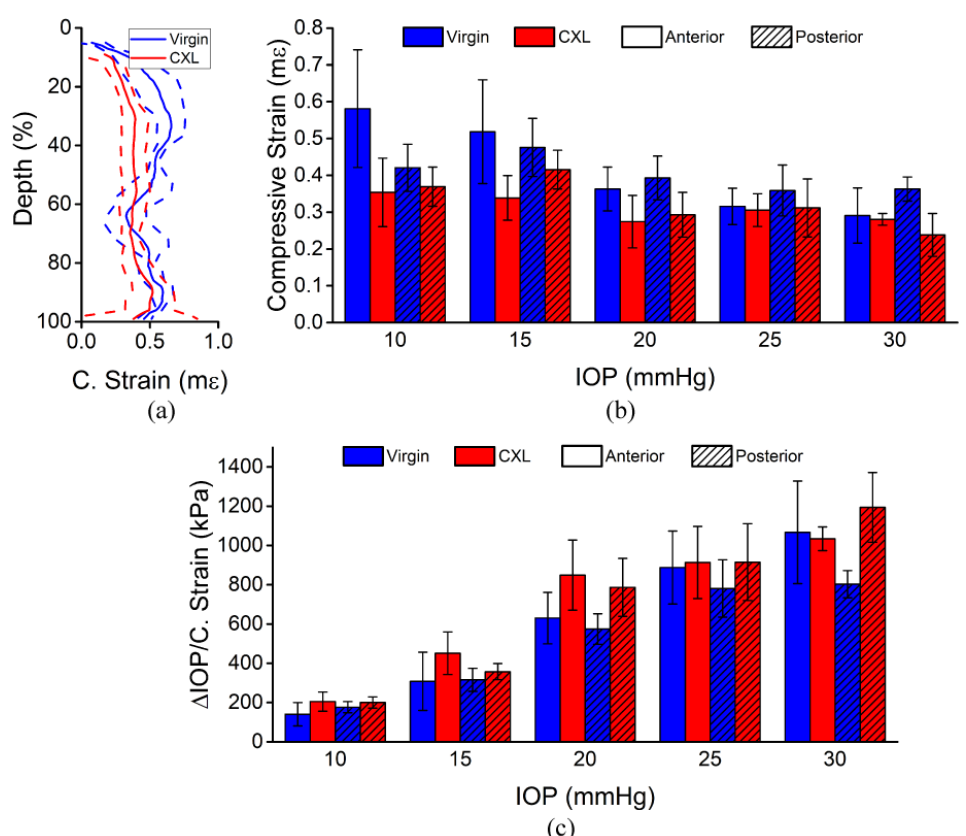
Figure 7. Depth-wise analysis of the half-CXL in situ rabbit cornea (N = 1). ( a ) Example depth-wise compressive strain averaged across the corresponding regions marked in Figure 5 at 15 mmHg IOP. The solid line is the average, and the dashed lines show one standard deviation of error. The data was normalized to the full thickness of the sample. ( b ) Average compressive strain and ( c ) stiffness quantified by Equation (2) for each region shown as the intra-region mean ± standard deviation.